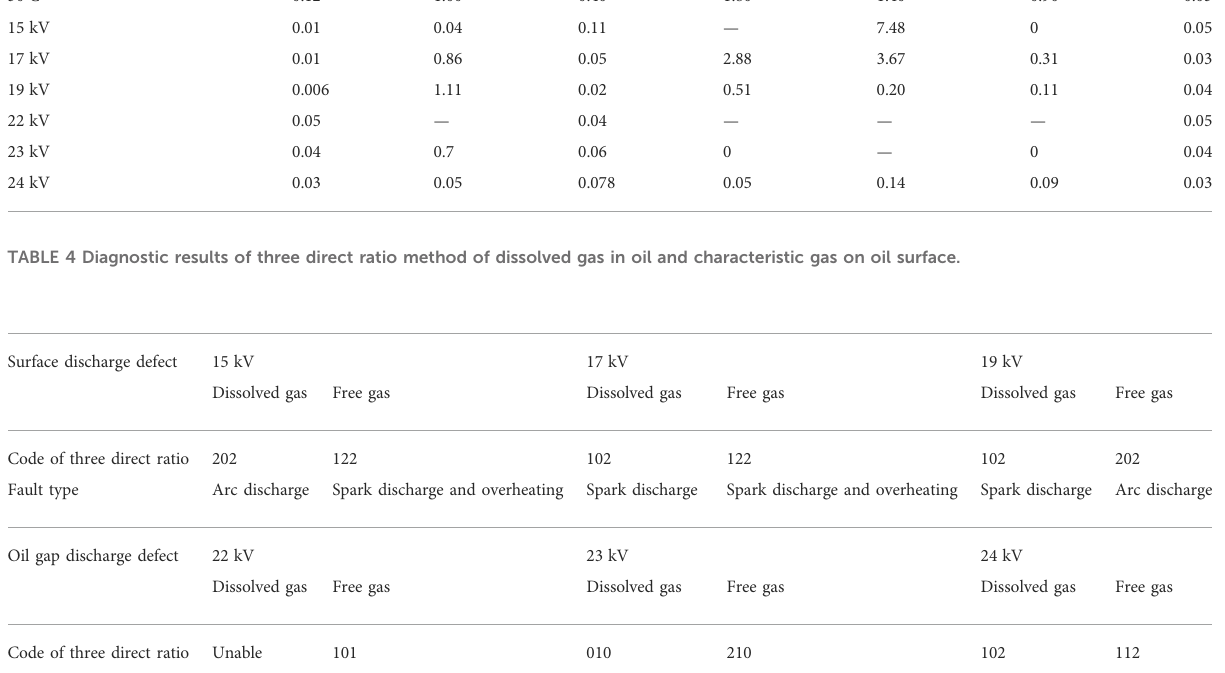
TABLE 3 Ostwald coef fi cient corresponding to characteristic gas under different discharge severity. Ostwald coef fi cient